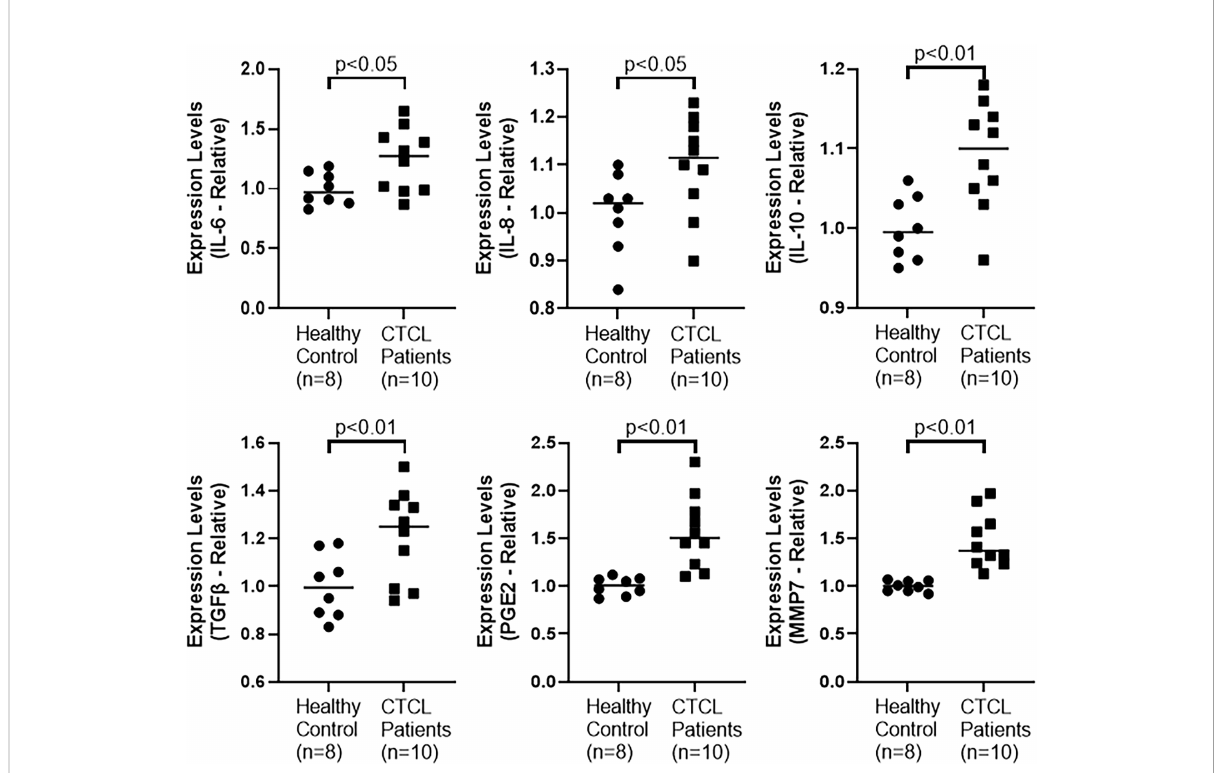
FIGURE 4 Levels of macrophages M2-related factors in CTCL patients were measured by ELISA, as described in Methods.